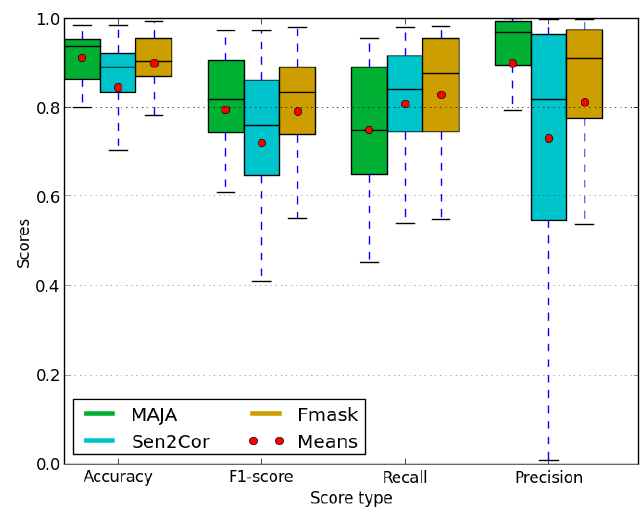
Figure 9. Mean and boxplot of each metric for the dilated cloud masks of the three processors compared with the dilated version of the ALCD cloud mask, over the 32 scenes. Red dots correspond to average values and the horizontal bars in the colored box to the 25%, 50% (median), and 75% quartiles. The dashed lines extend to minimum and maximum